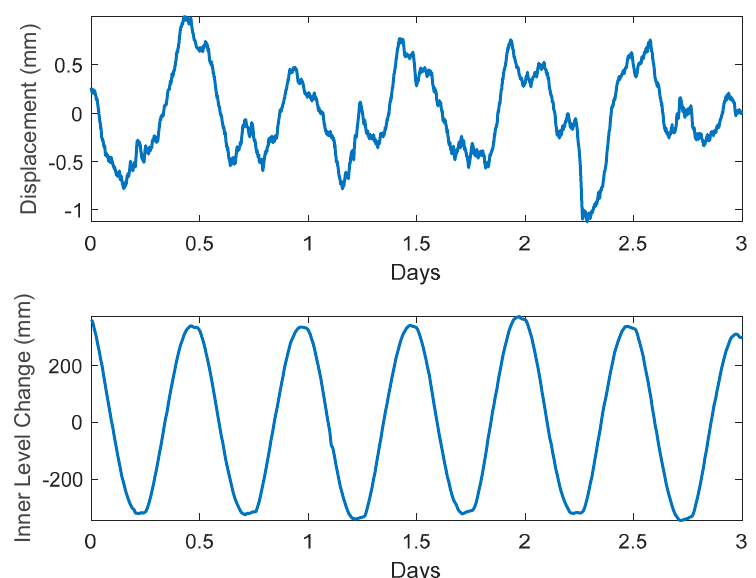
Figure 3. DAS measured displacement ( top ) compared with water level change inside the bladder, that induces strain in the fiber ( bottom ).